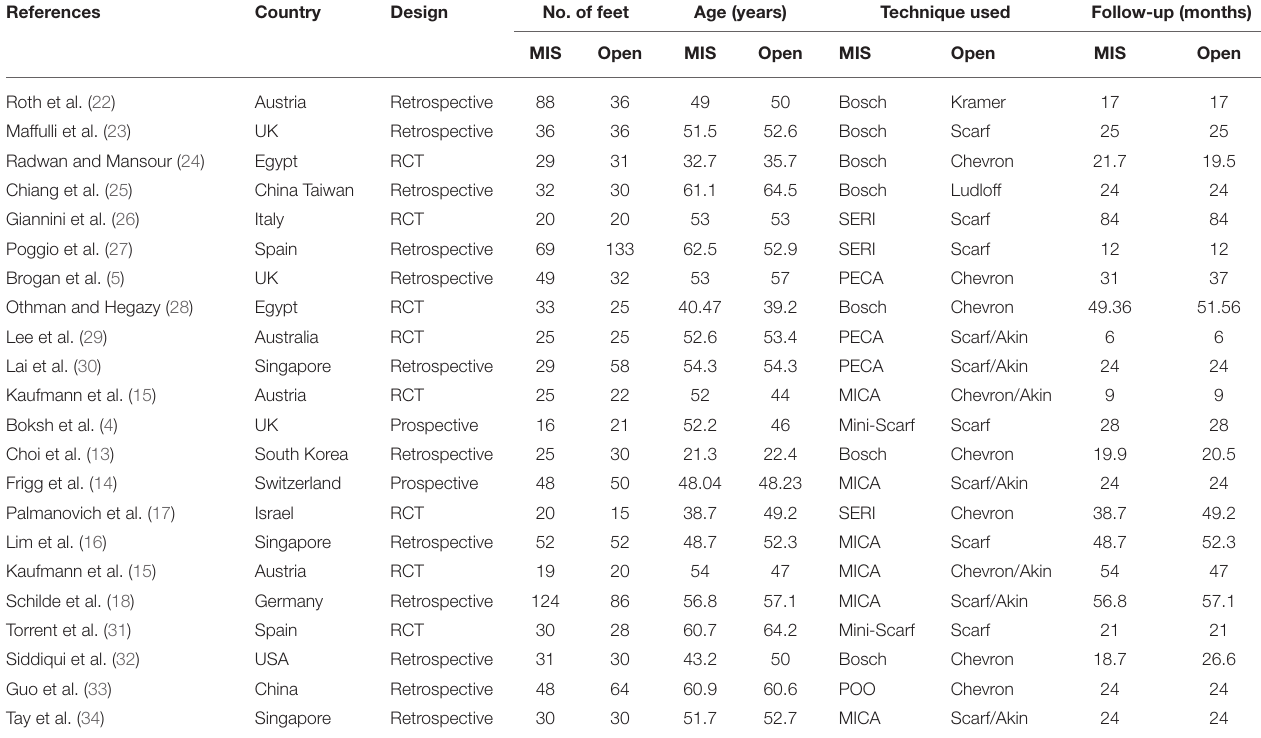
TABLE 1 | Characteristics of the included